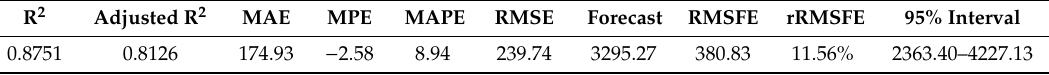
Figure 3. Catalyst market development forecast. Source: Own study. Table 4. Assessment of the model’s goodness of fit and forecast.